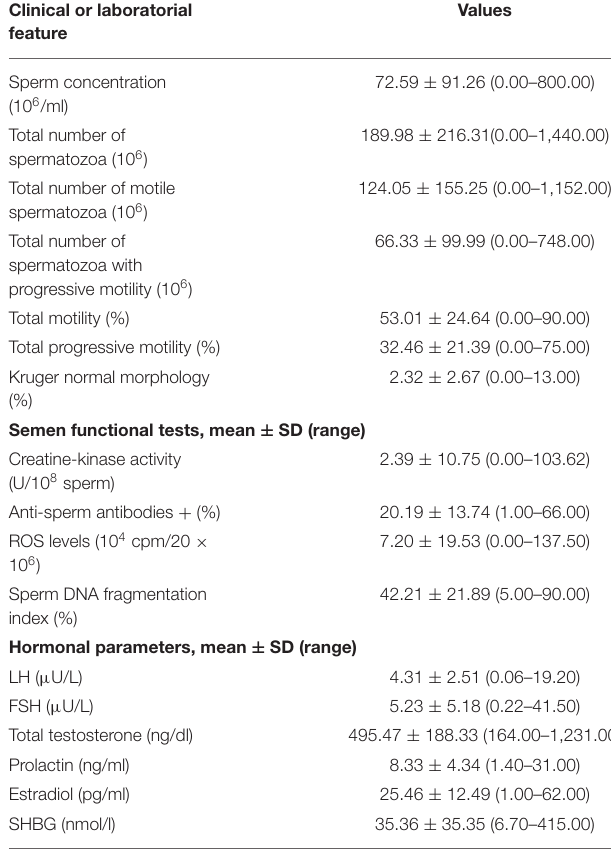
TABLE 1 | Baseline clinical and laboratorial characteristics of infertile patients ( n = 153),